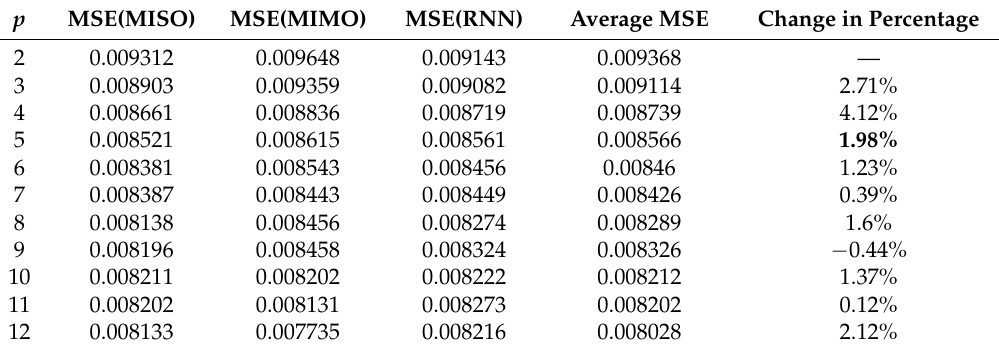
Table 3. MSE of every model for corresponding p and change in MSE as p